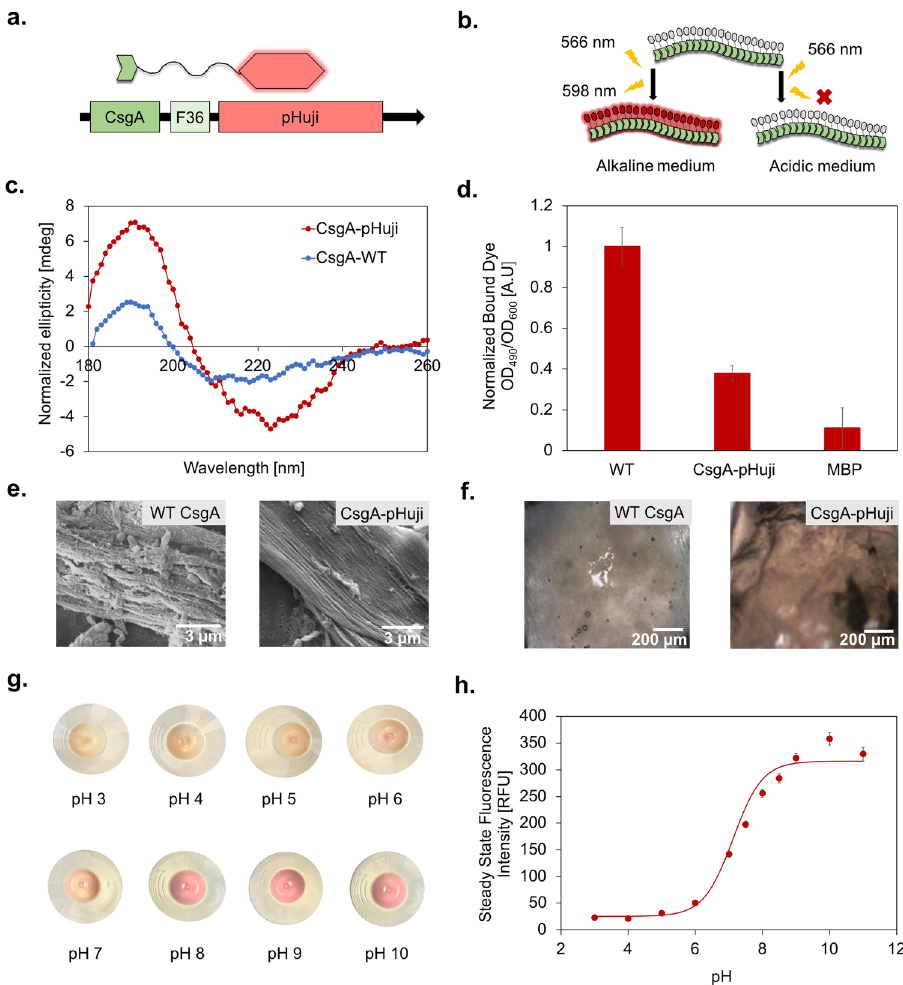
Figure 3. Genetic engineering and expression of responsive fluorescent curli fibers. ( a ) A scheme representing fusion of CsgA with a flexible linker and pHuji. ( b ) The fluorescence response of CsgA–pHuji under different pH conditions. ( c ) Circular dichroism spectra normalized for concentration of WT CsgA and CsgA–pHuji. ( d ) Normalized amount of dye bound to pellets of WT CsgA and CsgA–pHuji bacterial cultures via a Congo Red pull-down assay. ( e ) Optical microscope images of freshly purified WT CsgA and CsgA–pHuji hydrogels. ( f ) SEM images of WT CsgA and CsgA–pHuji producing bacterial cultures. ( g ) pH assays with concentrated pellets of CsgA–pHuji producing biofilms. ( h ) Mean steady state fluorescence response of CsgA–pHuji hydrogels to different pH buffers ranging from 3–11. The non-linear fit was performed using the Henderson–Hasselbalch equation (Eq.